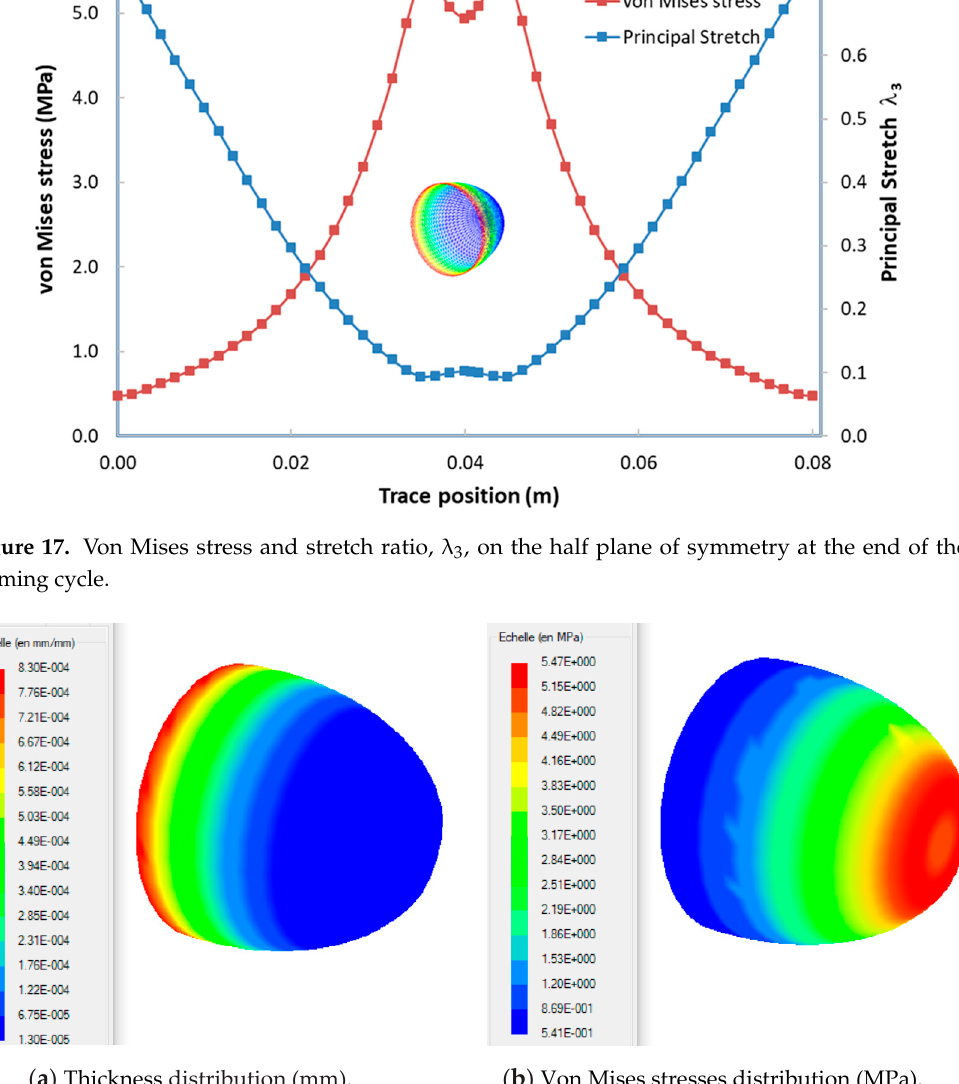
Figure 18. Thickness and von Mises stresses distributions in the thermoformed part: ( a ) Thickness distribution and ( b ) Von Mises stresses distribution.